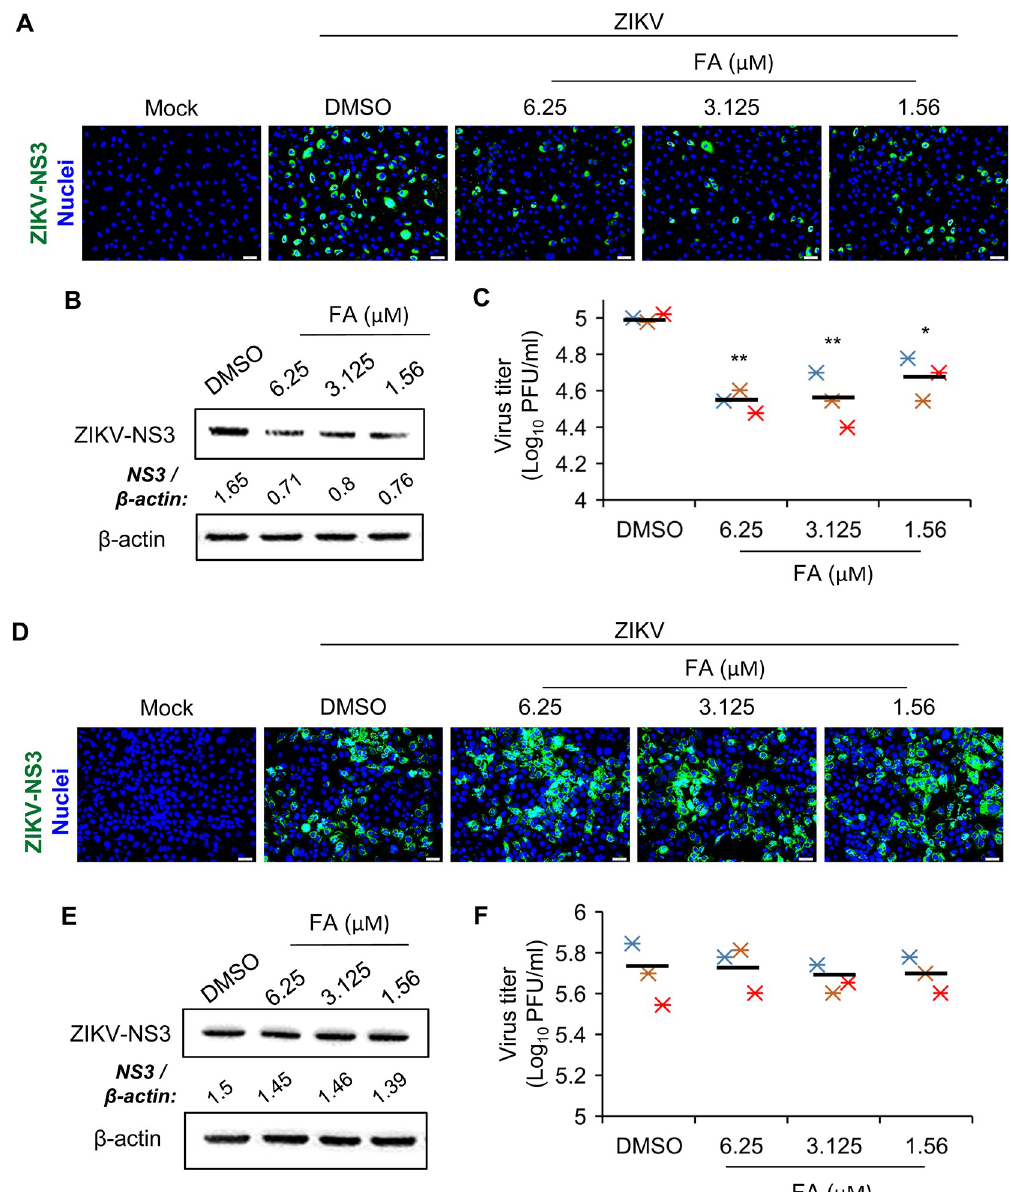
Fig 1. Folic acid (FA) displays antiviral effects against ZIKV infection in human umbilical vein endothelial cells (HUVECs). (A-C) HUVECs were pretreated with FA for 16 hr. Cells were infected with ZIKV in the presence of FA for 24 hr. Immunofluorescence microscopy was performed on cells immunostained for ZIKV-NS3 (green) and Hoechst for nuclei (blue) (A). Western blot analysis of the protein level of ZIKV-NS3 (B). Density ratios of respective protein and β -actin are shown in Western blot. Plaque-forming assay (PFA) of viral progeny production in culture supernatants (C). (D-F) Human trophoblast JEG-3 cells were pretreated with FA for 16 hr. Cells were infected with ZIKV in the presence of FA for 24 hr. Immunofluorescence microscopy was performed on cells immunostained for ZIKV-NS3 (green) and Hoechst for nuclei (blue) (D). Western blot analysis of the protein level of ZIKV-NS3 (E). Density ratios of ZIKV-NS3 and β -actin are shown in Western blot. Plaque-forming assay (PFA) of viral progeny production in culture supernatants (F). Data are mean (black bar) and individual values (n = 3 independent experiments). � P < 0.05 and �� P < 0.01 by Kruskal-Wallis, Bonferroni post-hoc test.